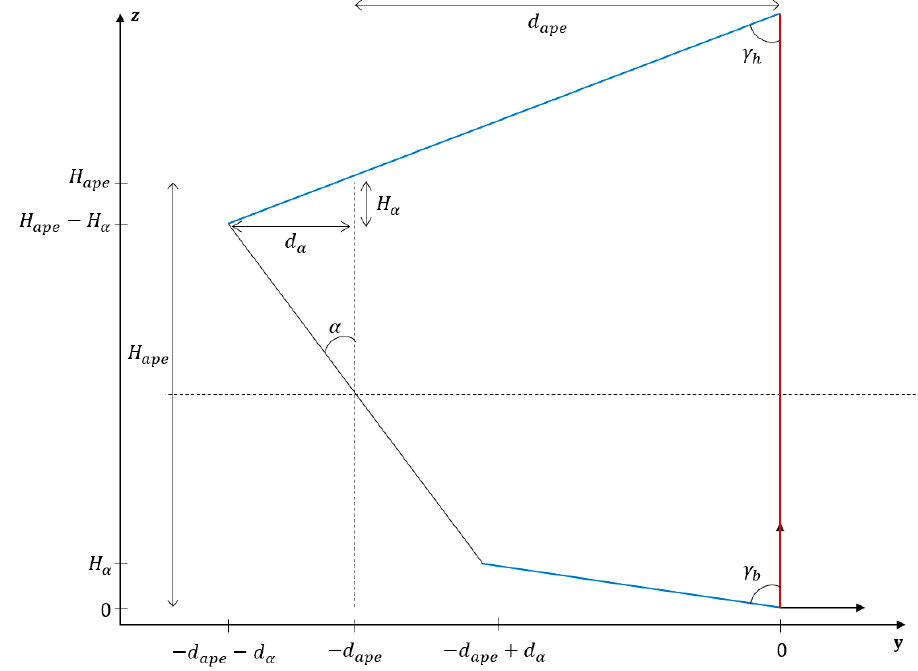
Figure 3. Schematic side view of a section of the (y,z) plane of a receiver showing the aperture inclination 𝛼 and the geometrical parameters associated with it.